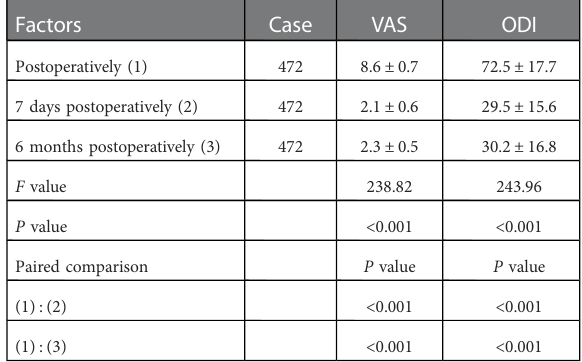
TABLE 2 Comparison of clinical indicators before and after